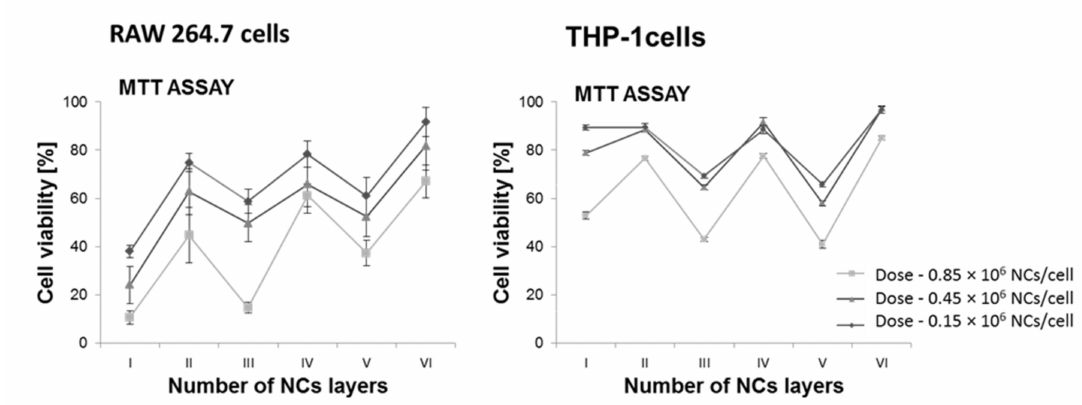
Figure 2. Cytotoxicity of obtained nanomaterials depending on their structure. Measurements for RAW 264.7 and THP-1 cells after a 24 h incubation with NCs. Detailed information